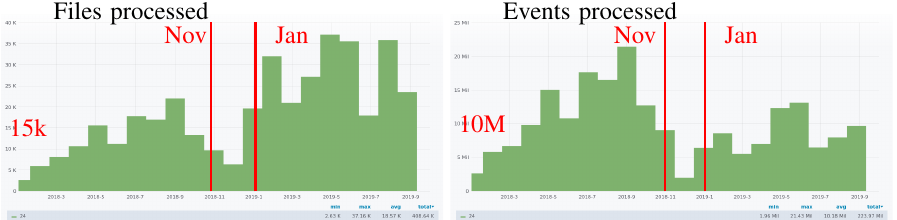
Figure 5. Number of processed files and events. Number of processed events decreased since Novem- ber 2018 because the system was submitting Event Service jobs. Since January 2019 the number of processed files increased because of increase in job quota.